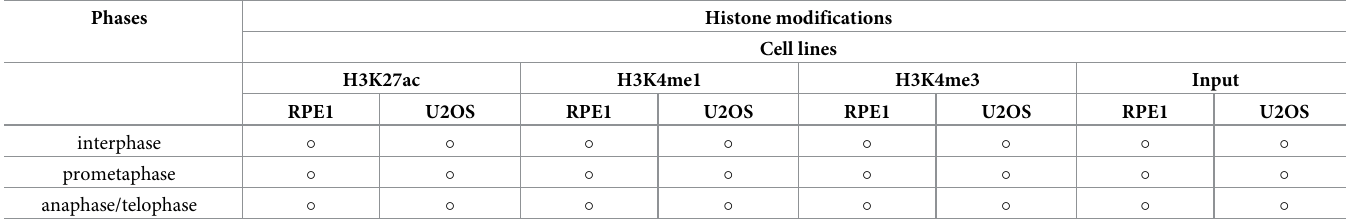
Table 1. Combinations of experimental conditions. Individual conditions are associated with two